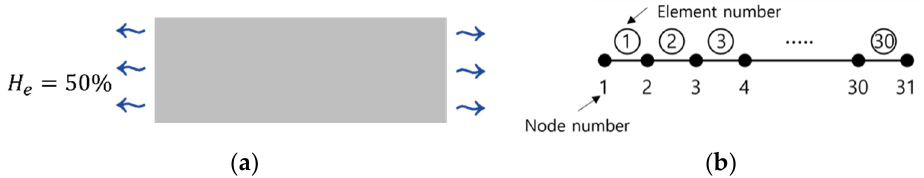
Figure 1. The schematic flow of the virtual experiment.